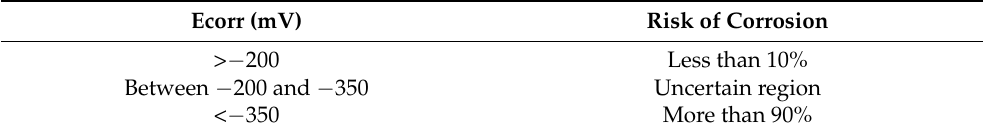
Figure 9. Corrosion rate and half-cell potential measurements. Table 4. Corrosion risk probability [36]. The potential values refer to a copper/copper sulphate reference electrode (SCE).